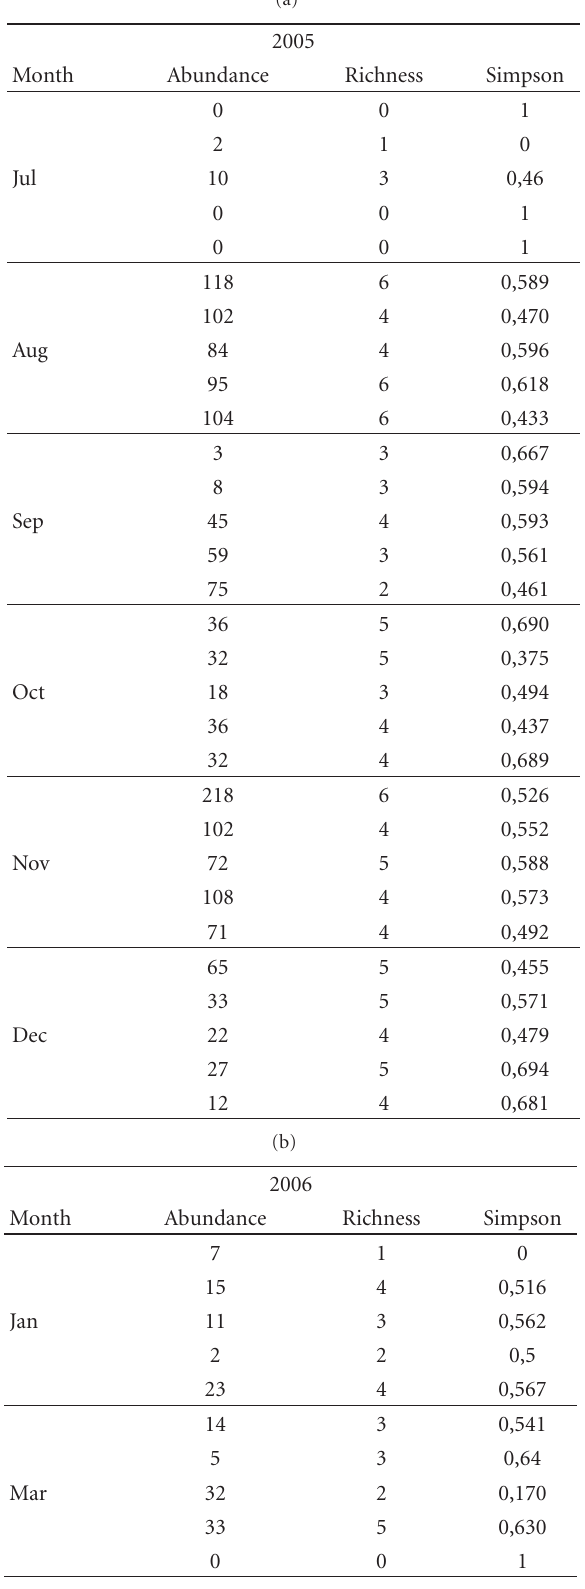
Table 3: Abundance, richness, and Simpson index of the species collected with five pitfall traps from July 2005 to July 2006.